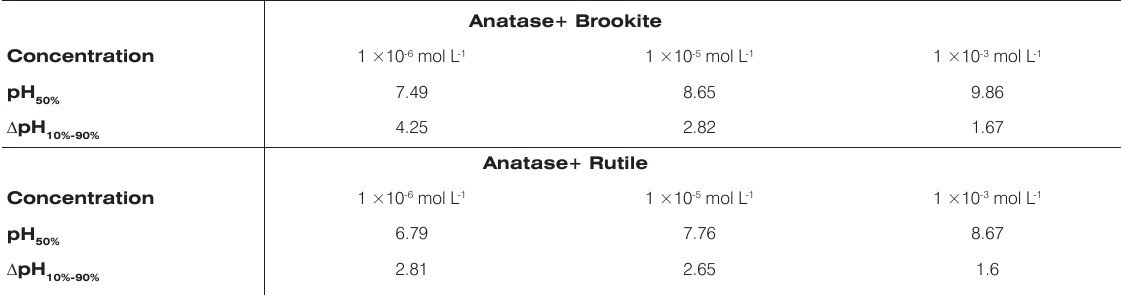
Table 5. Parameters of Zn(II) adsorption for biphase